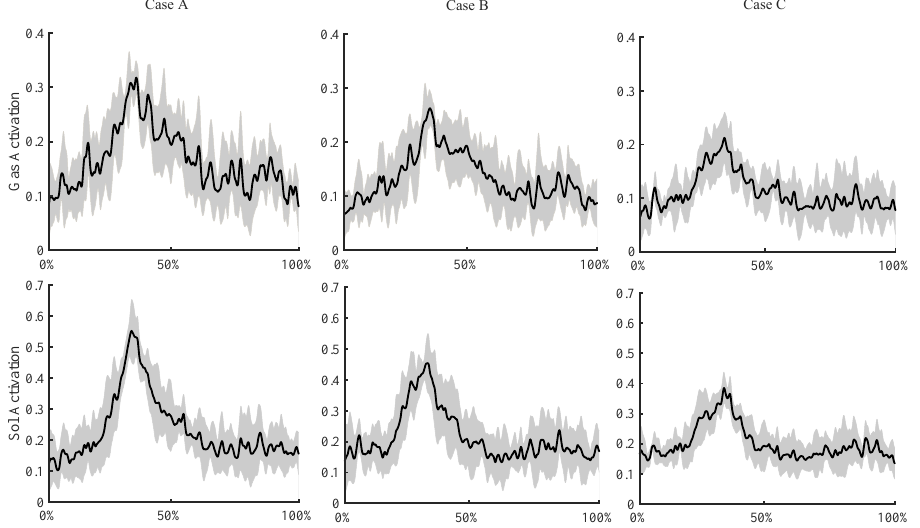
Figure 8. Muscle activation measurement results of participants in three case of